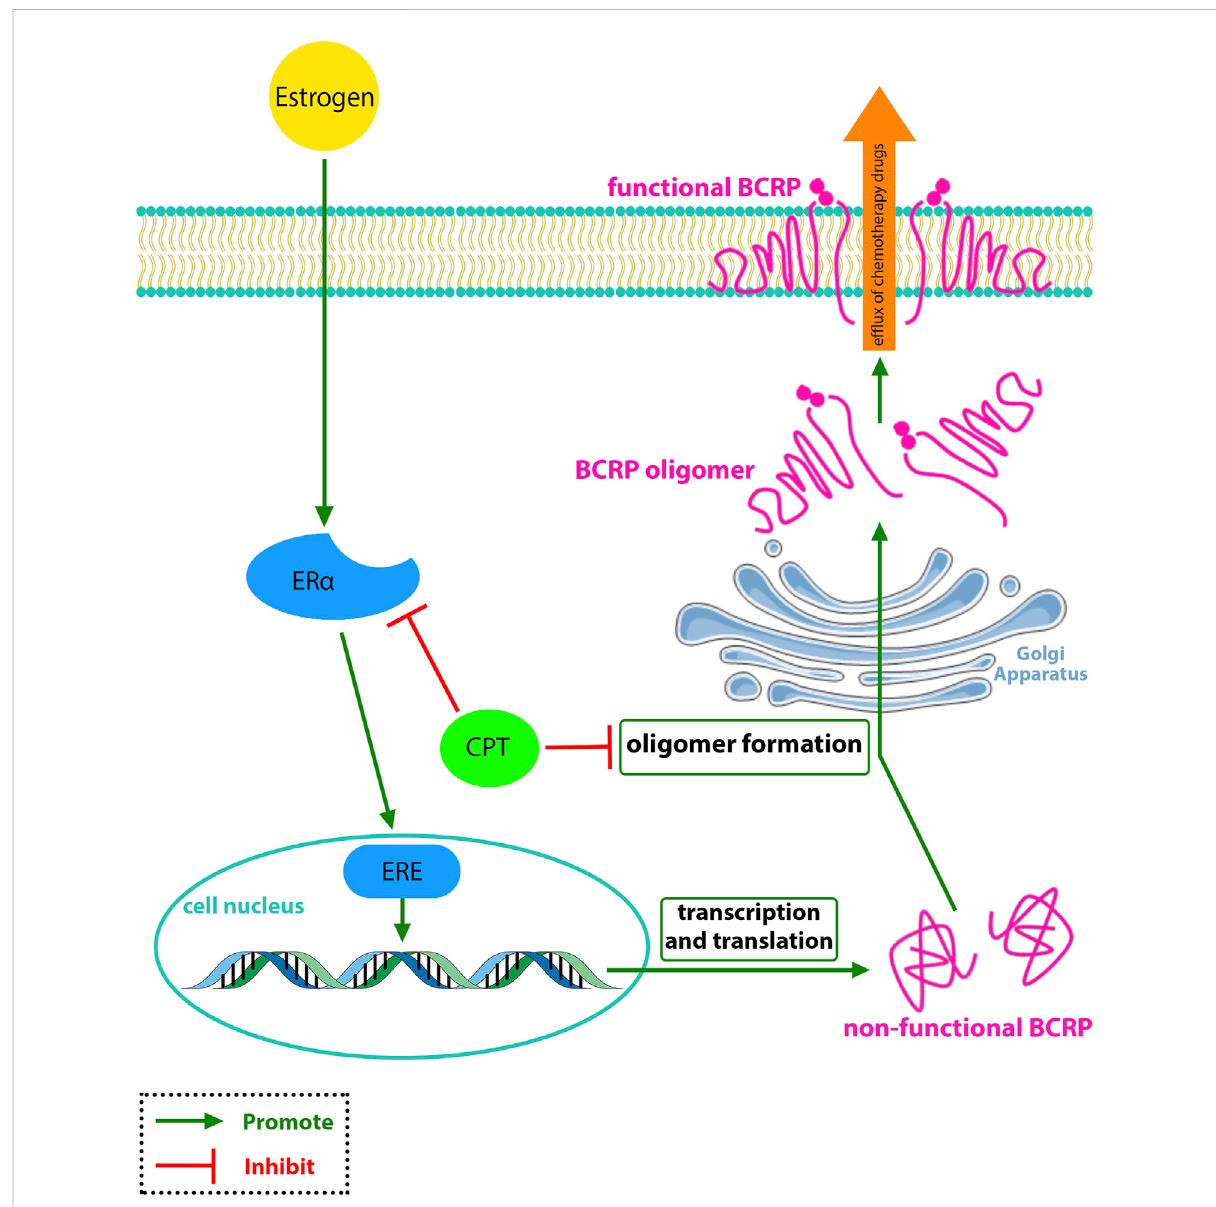
FIGURE 2 CPTinterfereswiththeoligomerformationofBCRPandinhibitstheBCRPfunctionintheef fl uxofchemotherapydrugswhichisassociatedwith